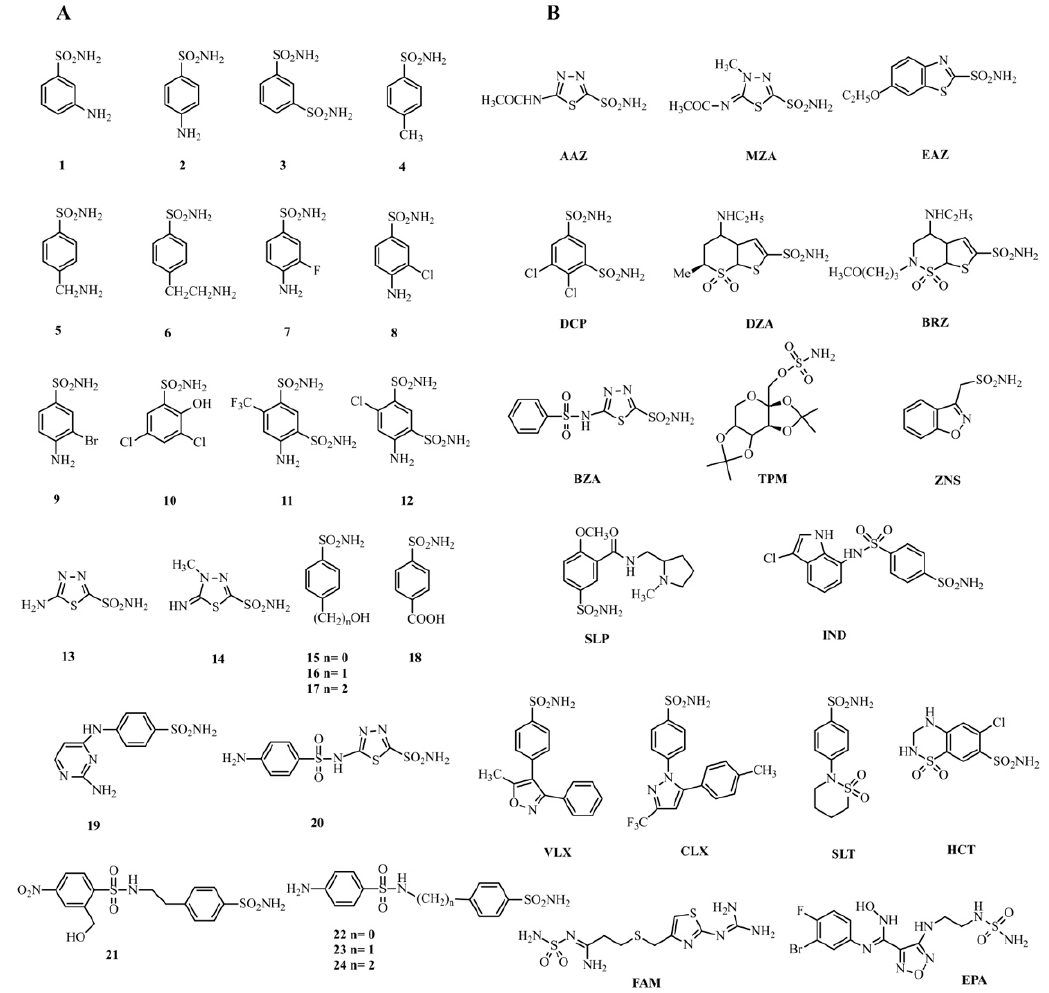
Figure 4. The structure of the compounds 1–24 (Panel A ) and AAZ-EPA (Panel B ) investigated as inhibitors of MpaCA. Table 1. CAI clinically used drugs identified with their short and commercial name.